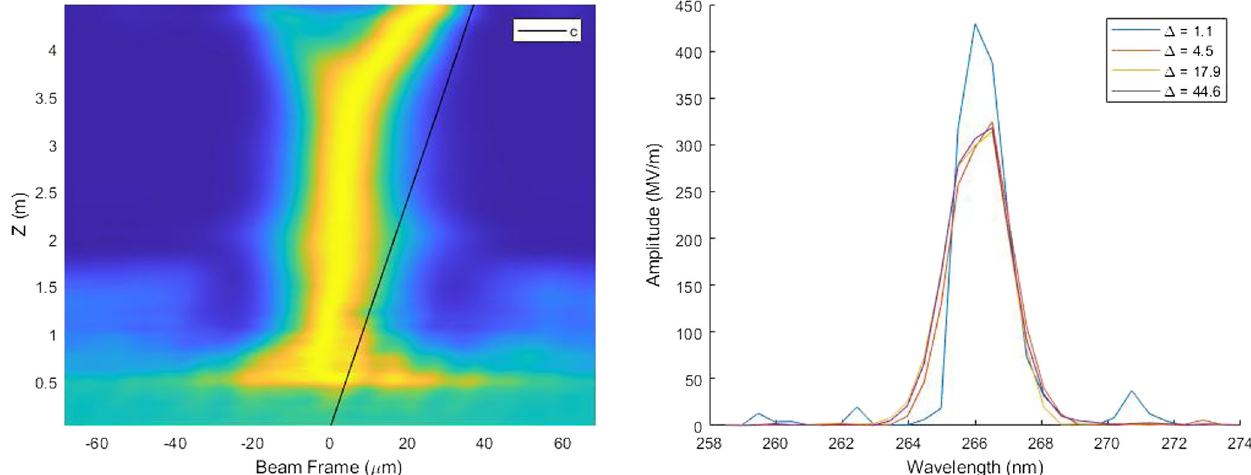
FIG. 4. GPT - FEL results for 31 frequencies, each with a single gaussian transverse mode. (a) Waterfall plot of normalized power. (b) Spectrum at P ¼ 0 . 1 GW for different thresholds on SDE interaction. Δ is the ratio of L to the theoretical gain length. Numerical thresh errors occur when Δ ⪅ 1 because noise in the small amplitude, higher order modes quickly excite significant changes in the mode parameters. This suggests L should be an order of magnitude larger than the theoretical gain length for convergent thresh